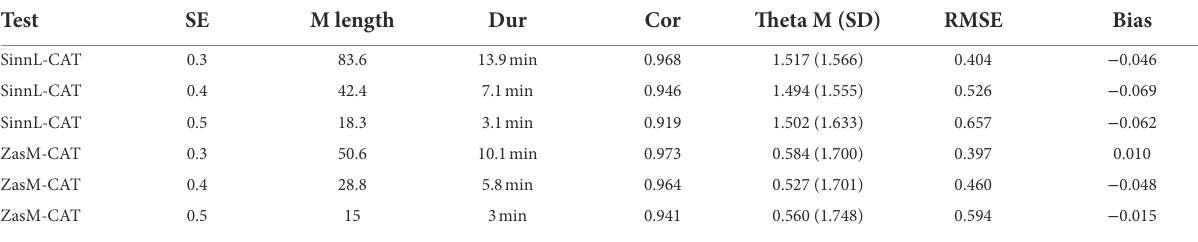
TABLE 4 Results of CAT simulations of different standard errors (SE = 0.3, SE = 0.4, SE = 0.5) with 1,000 simulees each and the resulting test lengths in items and minutes, the correlation between estimated θ - and actual θ -values, the mean and standard deviation of the estimated θ -values as well as RMSE- and bias values.